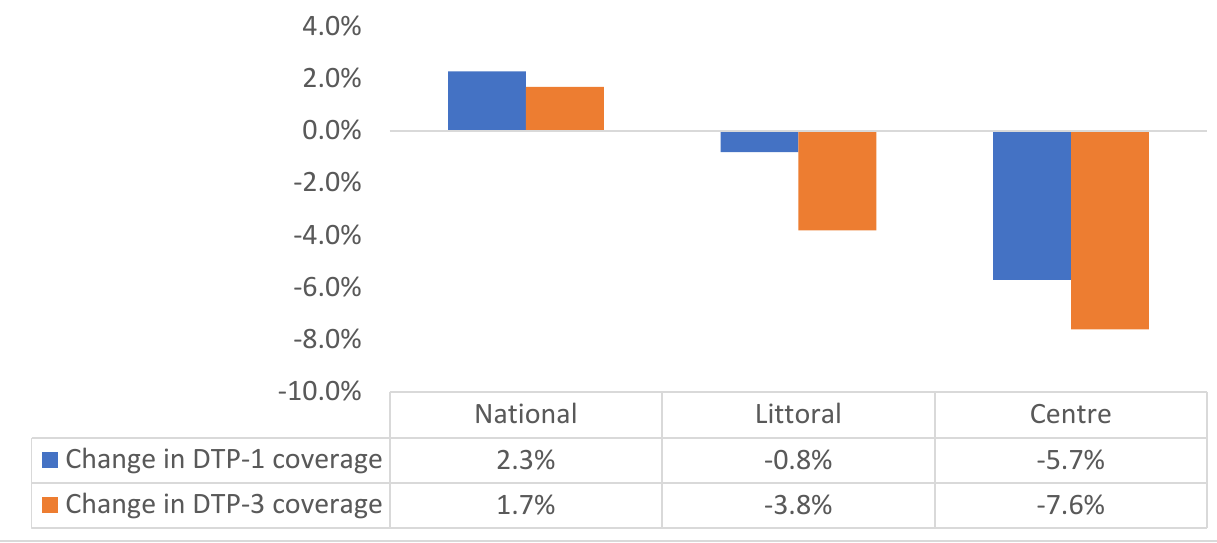
Figure 1. Change in DTP-1 and DTP-3 coverage in hotspot regions during the pandemic.